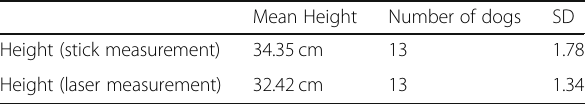
Table 3 Comparison of height measurement results